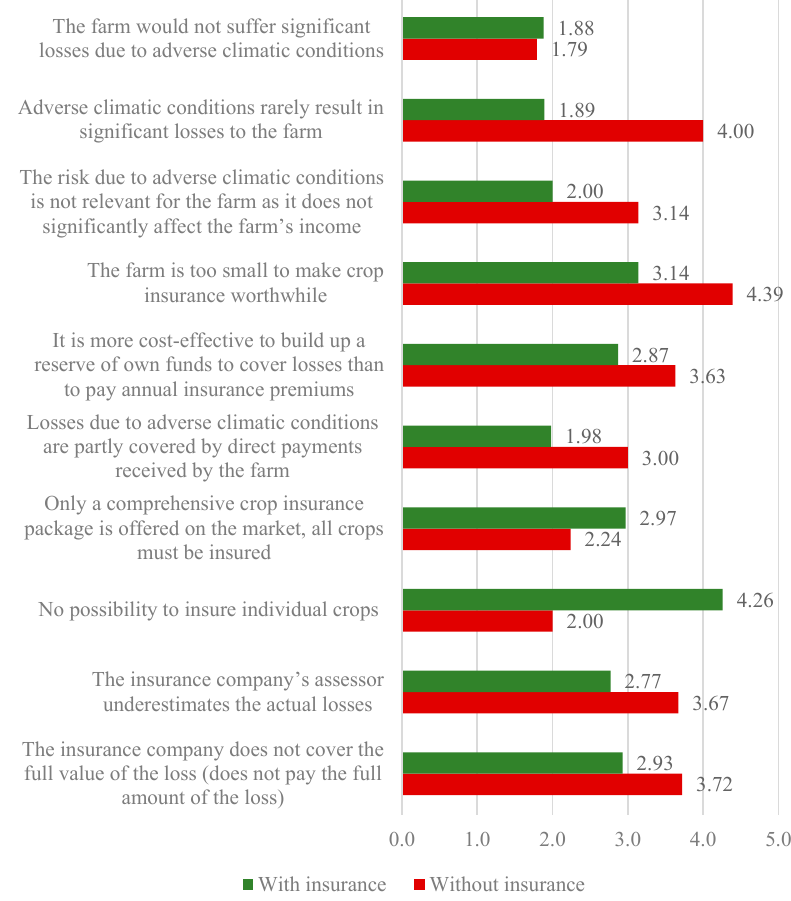
Figure 4. Reasons why farmers are hesitant about crop insurance.